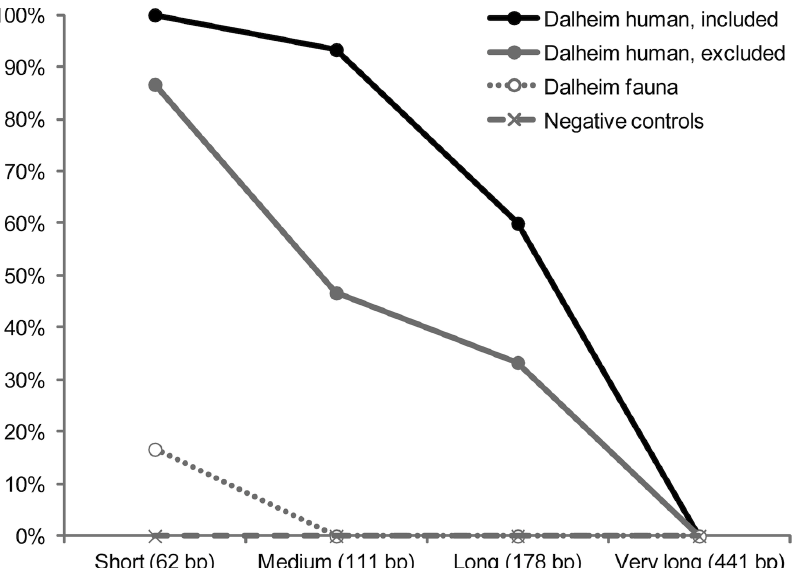
Figure 2. Results of ancient DNA authentication test of Dalheim human and control samples as determined by real-time PCR. Well preserved Dalheim human samples included in this study show strong evidence of asymmetrical molecular behavior consistent with ancient DNA. Poorly preserved Dalheim human samples also show evidence of asymmetrical molecular behavior, but they were excluded from further analysis because their poor amplification success rate ( , 50% a the 111 bp length used for genotyping) makes them vulnerable to amplification bias and allelic dropout. Control samples show no or spurious amplification. Sample sizes are as follows: Dalheim human (included in analysis), n=10; Dalheim human (excluded from analysis), n=5; Dalheim fauna, n=2; negative controls, n=4. All amplifications were performed in triplicate.